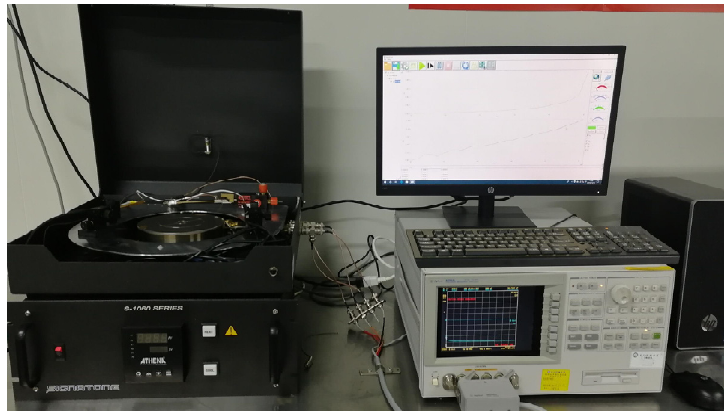
Figure 9. The junction capacitance parameter test platform for diodes.